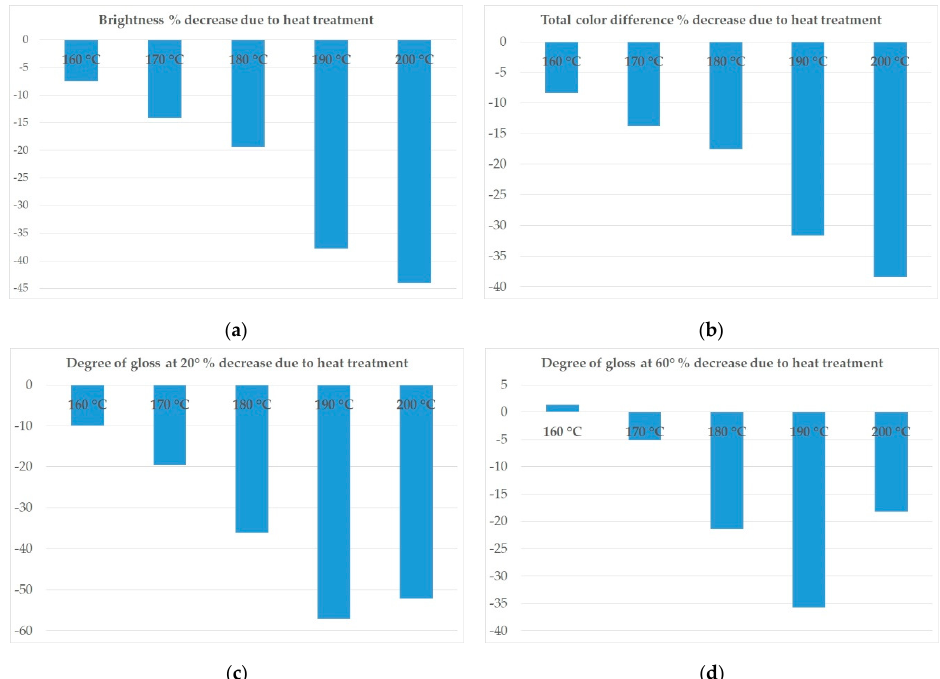
Figure 14. Graphic visualization of the effect of heat treatment temperature to percentage changes of ( a ) brightness, ( b ) total colour difference, ( c ) degree of gloss at 20°, and ( d ) degree of gloss at 60°. The correlations between the individual observed quantities, regardless of the level of heat treatment, are statistically significant (Figure 15). Logically, highly heavy dependencies were demonstrated between total colour difference and brightness (r = 0.9968), gloss and brightness (r = 0.8110).